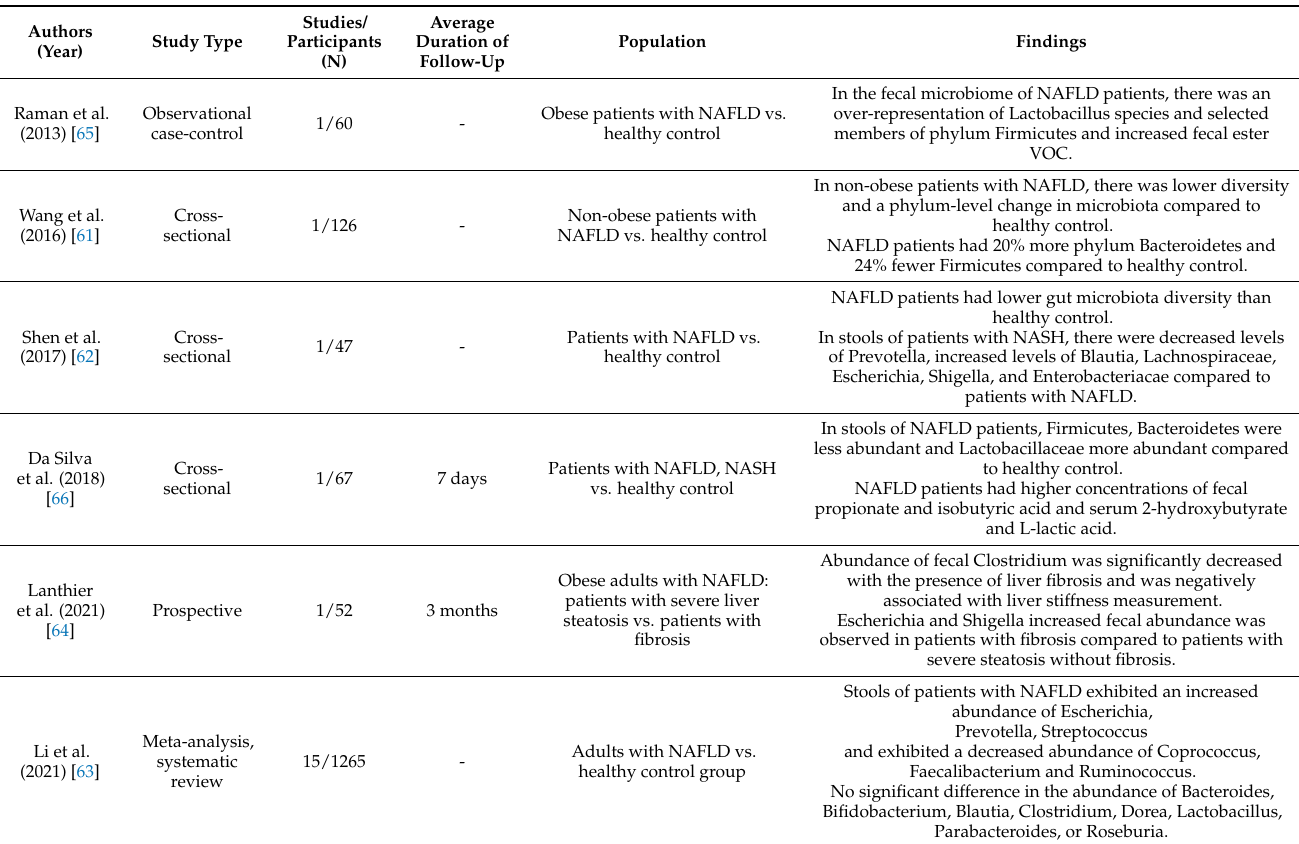
Table 2. Associations between NAFLD and gut